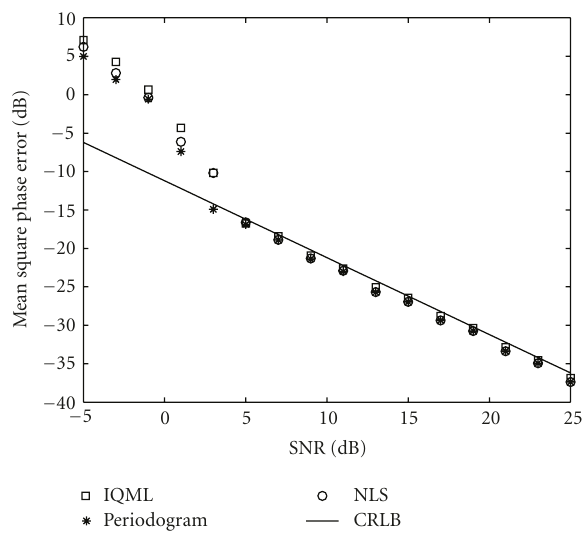
Figure 27: MSE for φ of 2D single complex